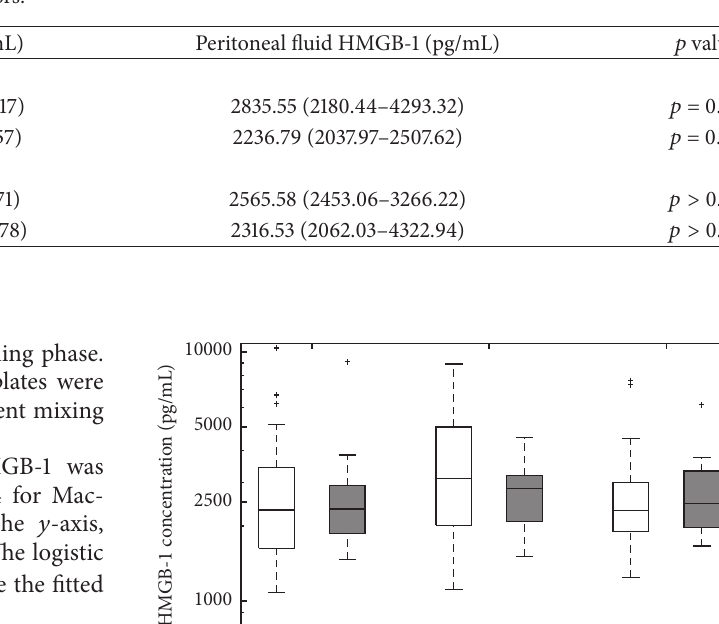
Table 1: Comparison of median plasma and peritoneal fluid HMGB-1 levels with IQR provided in the parentheses. Results based on data available for 44 patients: 29 survivors and 15 nonsurvivors.